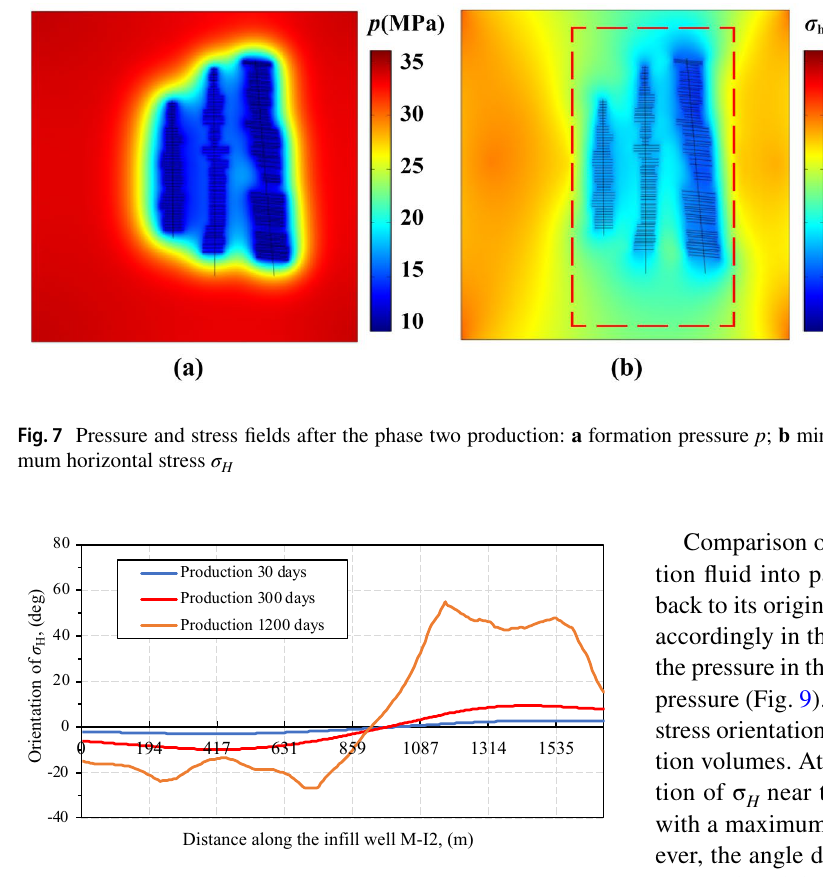
Fig. 8 Orientation of maximum horizontal stress along the M-I2 wellbore at different production time spans